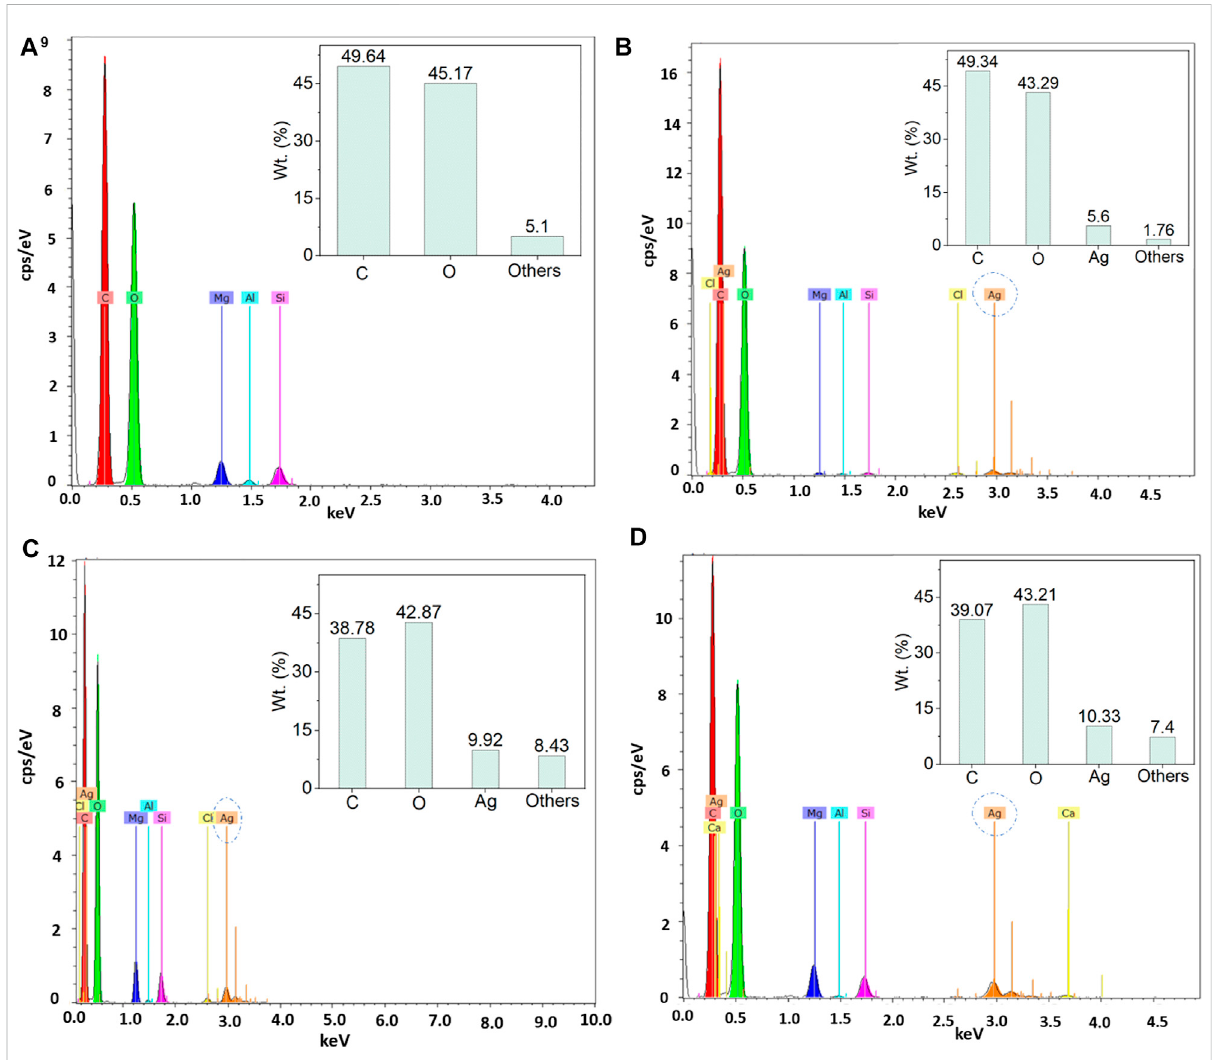
FIGURE 4 EDX analysis of control and nanosilver deposited kraft paper samples: (A) P@C, (B) P@Ag1, (C) P@Ag2, and (D) P@Ag3.